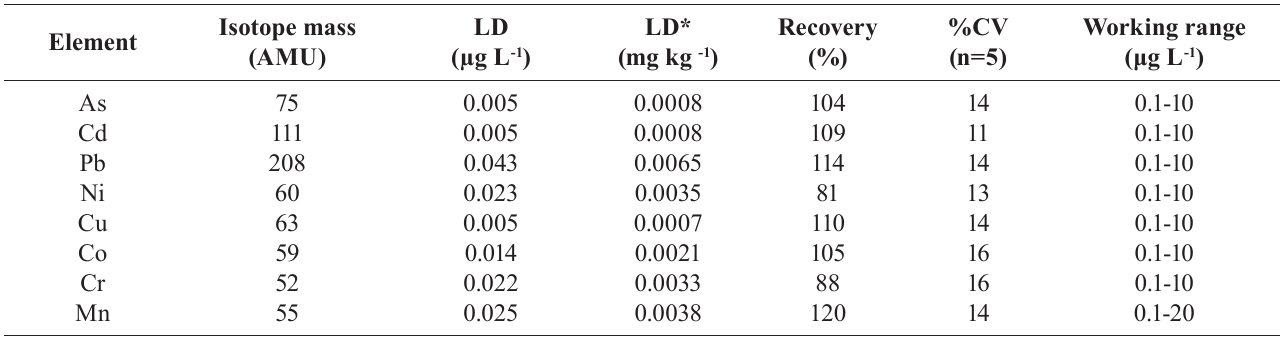
TABLE II - ICP-MS results of the validation tests of the analyzed elements